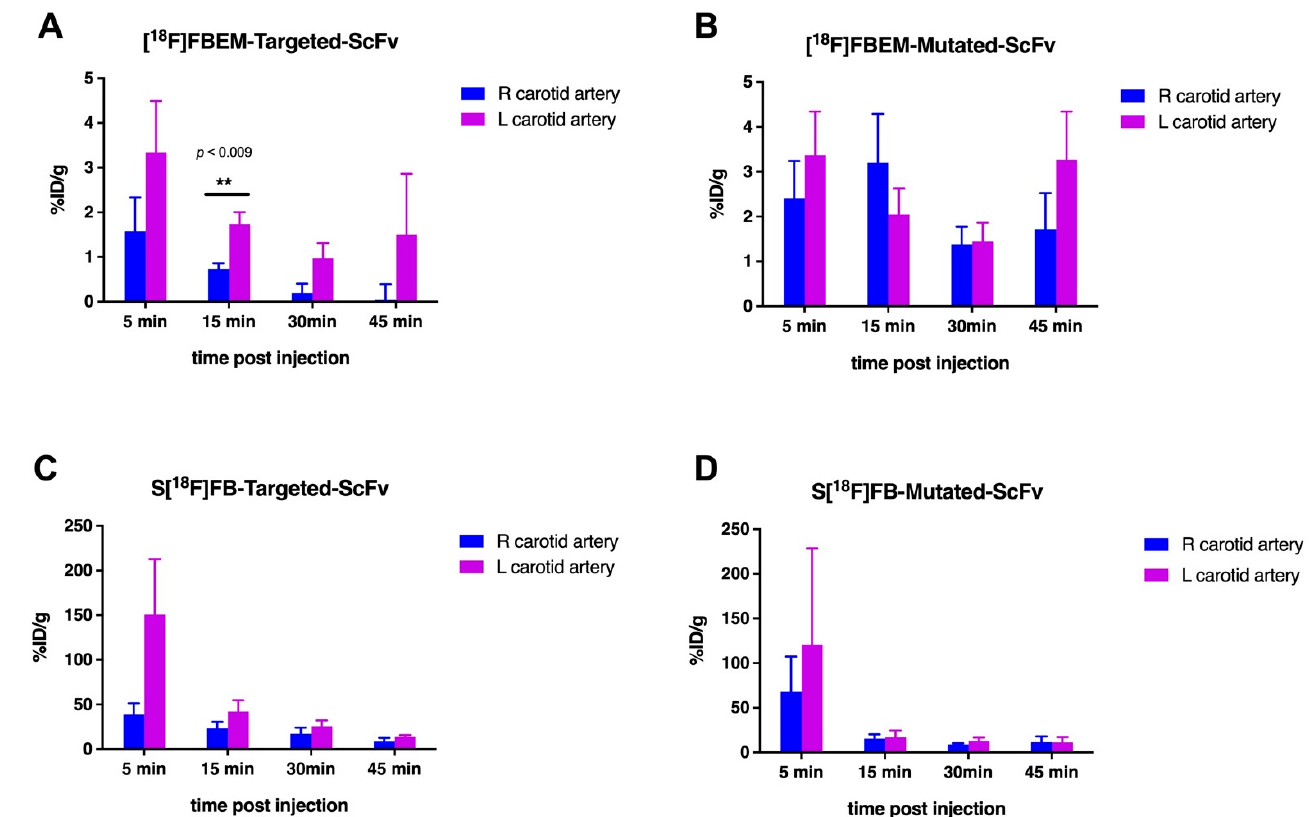
Figure 3. A comparison of radioactivity uptake between injured and intact vessels. ( A ) represents radioactivity uptake in mice that were injected with [ 18 F]FBEM-targeted-ScFv over time. At the 15-min time point, there was a significant difference between the injured vessel (left carotid) and the intact vessel (right carotid). ( B ) shows that there was no significant difference in radioactivity uptake, between the injured and non-injured vessels, at all time points investigated (n = 5). ( C , D ) show the same comparison for the S[ 18 F]FB-labelled scFv, with significant uptake of S[ 18 F]FB-targeted ScFv observed at 5 min p.i. For both tracers, the values have been normalised to having brain tissue as the background tissue. Data were subjected to 2-tailed student t -test (** indicates p ≤ 0.01).